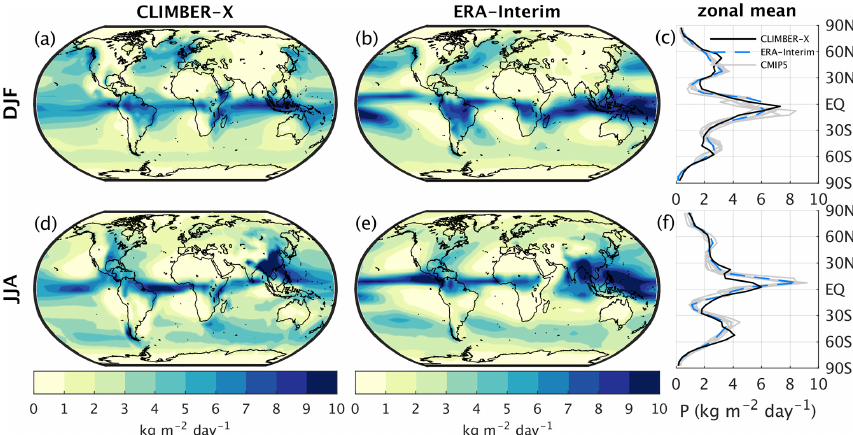
Figure 9. Precipitation modelled by CLIMBER-X for (a) DJF and (d) JJA compared to ERA-Interim reanalysis (Dee et al., 2011) (b, e) . The zonal mean is additionally compared to CMIP5 models in panels (c) and (f) .